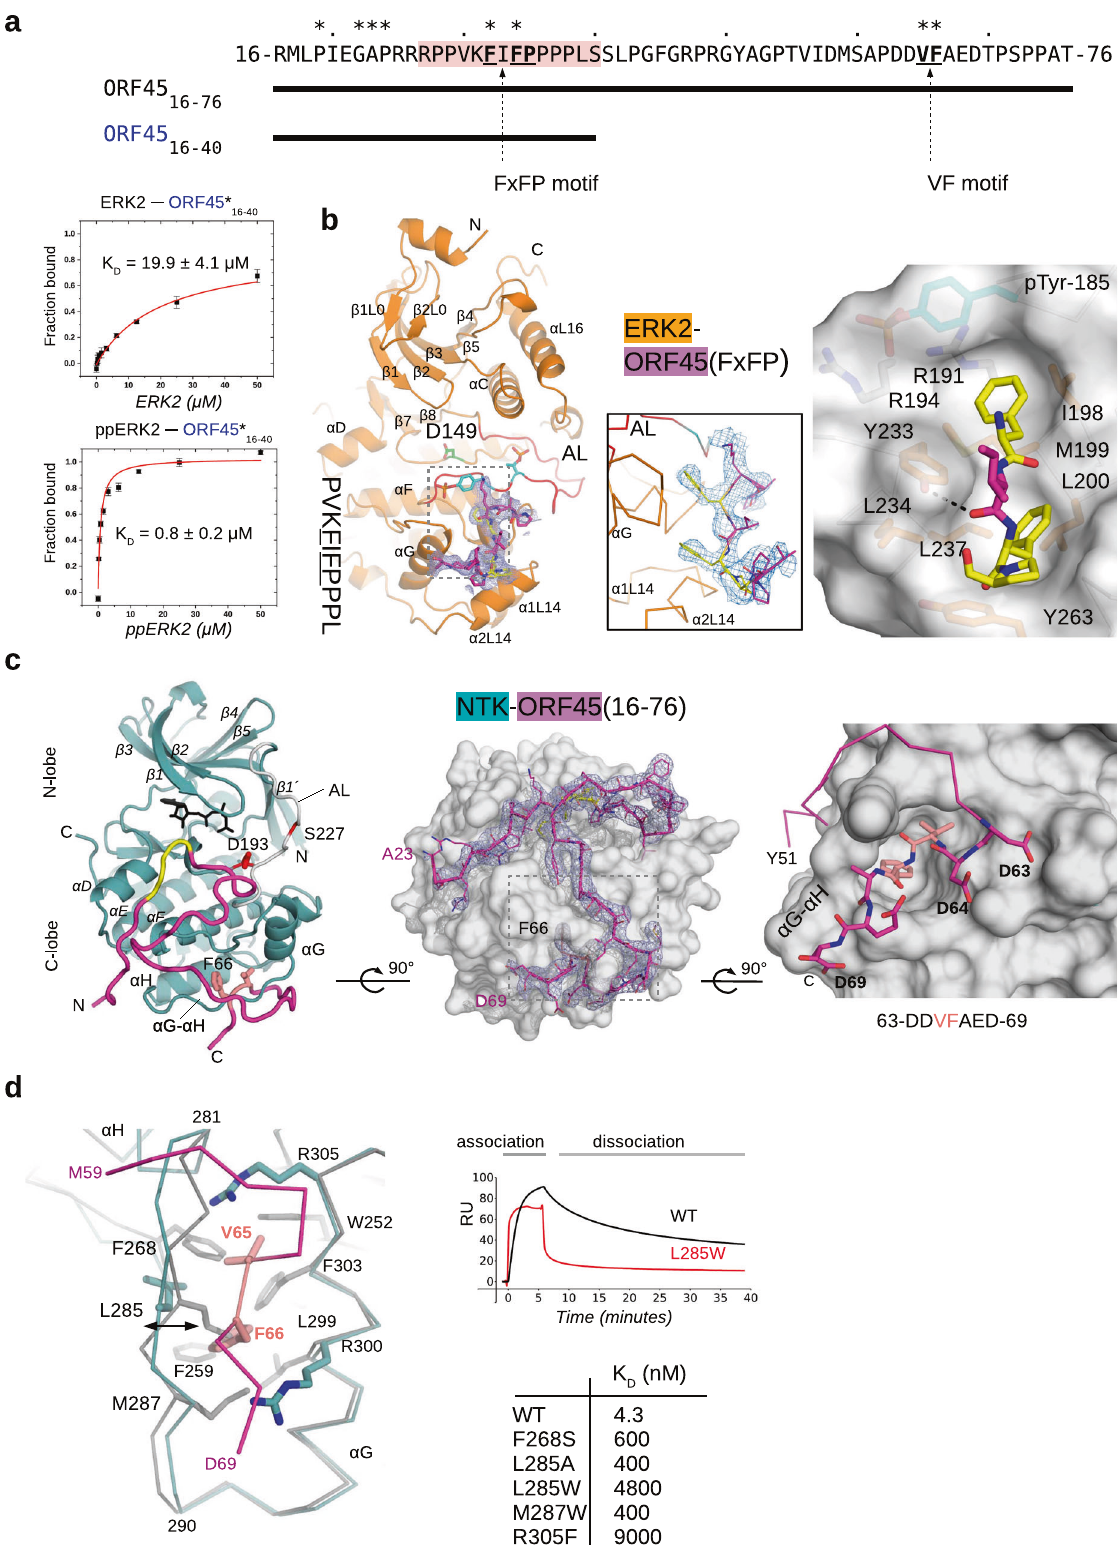
hydrophobic pocket between the α G- α H loop and helix G (outlined by W252, F259, F268, L285, M287, L299, F303 and also involving R300 and 305), while D63-64 and D69 make H-bonds or salt bridges with K304, N309, and R300, respectively. The ORF45 contact surface on the NTK was validated by mutating critical residues at this region. As expected, binding af fi